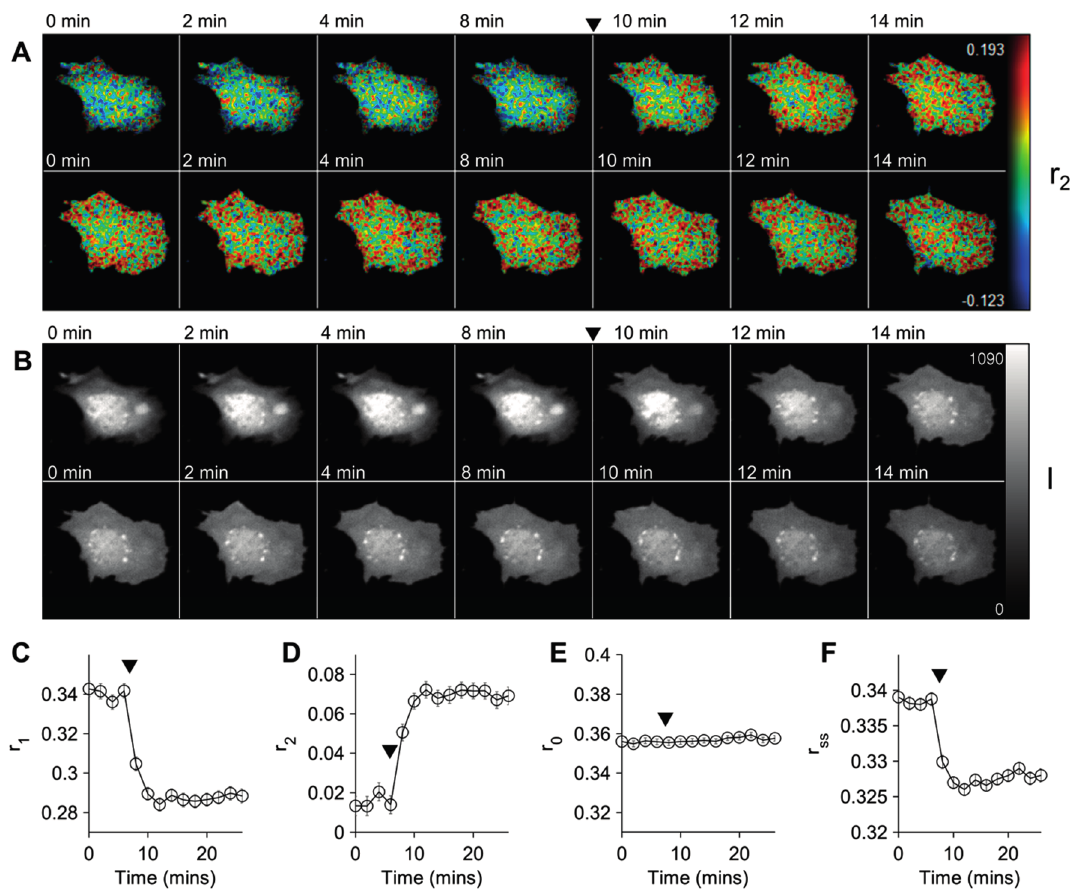
the FRET associated anisotropy component r 2 and a corresponding reduction in the rotational component r 1 , are observed. The total initial anisotropy r 0 = r 1 + r 2 , which is not constrained in the fitting, appears to remain unchanged as expected, indicating the model adequately describes the data.